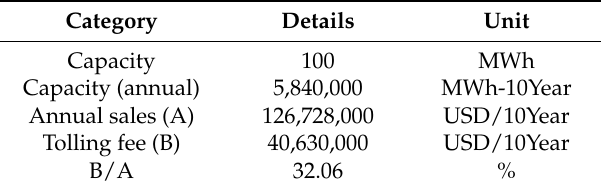
Table 3. Tolling fee of 10-year energies contract (modified from